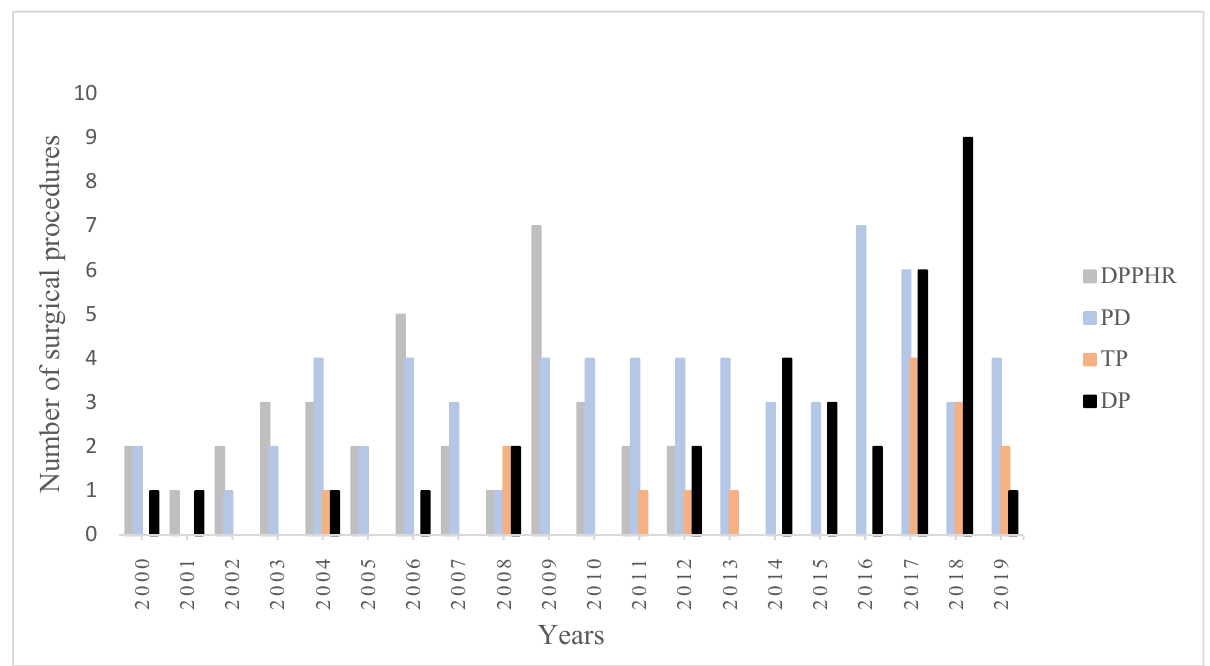
Figure 2. Trends over time in the surgical procedures for chronic pancreatitis at Karolinska University Hospital. DPPHR: duodenum-preserving pancreatic head resection; PD: pancreatoduodenectomy; TP: total pancreatectomy; and DP: distal pancreatectomy.